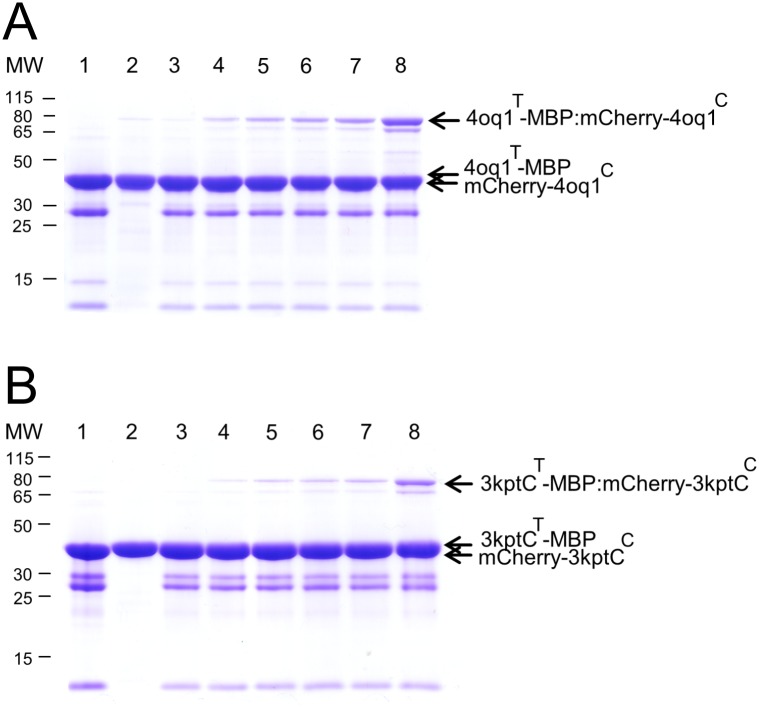
Covalent intermolecular bond formation assay between tag-MBP and respective mCherry-catcher proteins.Purified tag-MBP and mCherry-catcher proteins were mixed each at 15 μM (final concentration) for 24h at 25°C with shaking at 500 rpm before boiling (10min, 95°C) and SDS-PAGE with Coomassie staining. (A) Time course of 4oq1T-MBP and mCherry-4oq1C reaction. (B) Time course of 3kptCT-MBP and mCherry-3kptCC reaction. Spontaneous isopeptide bond formation was detected between the protein partners used. Covalent product increased over time. Lane 1: mCherry-catcher input (30μM), lane 2: tag input (30μM), lane 3: 0h, lane 4: 1h, lane 5: 2h, lane 6: 3h, lane 7: 4h, lane 8: 24h. Same volume of samples were loaded. MW stands for molecular weight (kDa).